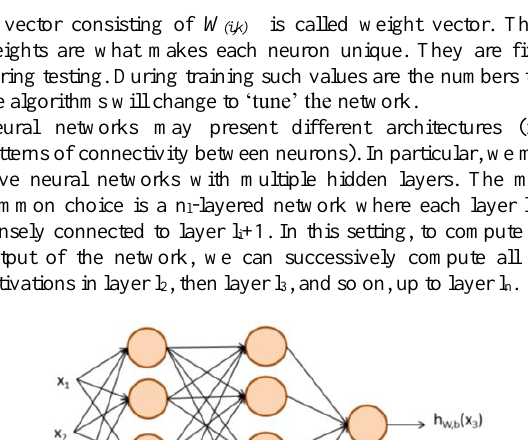
Figure 6. Regression lines for training, validation, and test datasets.